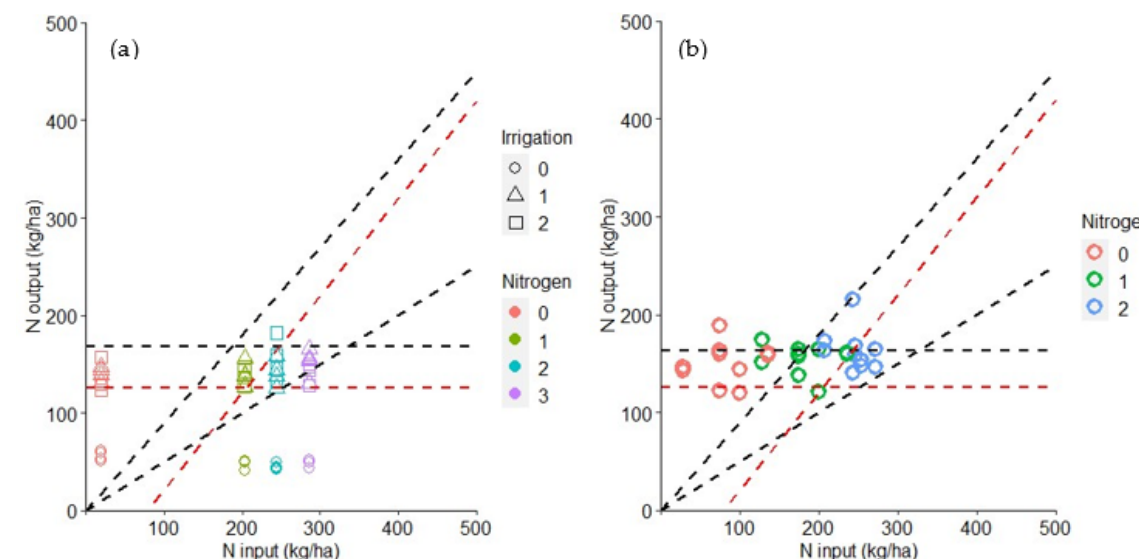
Figure 4. The effect of different nitrogen (N) fertiliser and irrigation treatments on potato yield, nitrogen use efficiency (NUE) and environmental impacts as represented in the two dimensional N input-output diagram for the 2017 experiment ( a ) and the 2018 N experiment ( b ). In 2017, the three irrigation treatments were (0) no-irrigation, (1) farmer’s irrigation and (2) full irrigation. The four N treatments were (0) zero N fertiliser (N0), (1) 184 kg N ha − 1 (N1), (2) 225 kg N ha − 1 (N2), (3) 267 kg N ha − 1 (N3). The dots indicate the different irrigation treatments (shape) and N treatments (color). In 2018, the three N fertiliser treatments were 0 (N_low, 9–117 kg N ha − 1 ), 1 (N_medium, 109–181 kg N ha − 1 ), 2 (N_high, 189–252 kg N ha − 1 ). The dots with three colors indicate the results of the three N treatments respectively with 10 samples per N treatment (i.e., two fields per farm x five farms). N input included both N fertiliser input and N deposition (19 kg N ha − 1 ). N output was the N removed by harvested product (tubers). The black horizontal line indicates the upper target yield (i.e., 50 and 49 ton FM ha − 1 for 2017 and 2018, respectively), and the red horizontal line represents the lower target yield (i.e., 37.5 ton FM ha − 1 ). Yields are expressed in N uptake in tuber yield. The two diagonal black lines indicate the lower (50%) and upper (90%) target values for NUE, not accounting for input from mineral soil N. The diagonal red line indicates the upper boundary of N surplus (N input minus N output) (80 kg ha − 1 ) for sustainable N